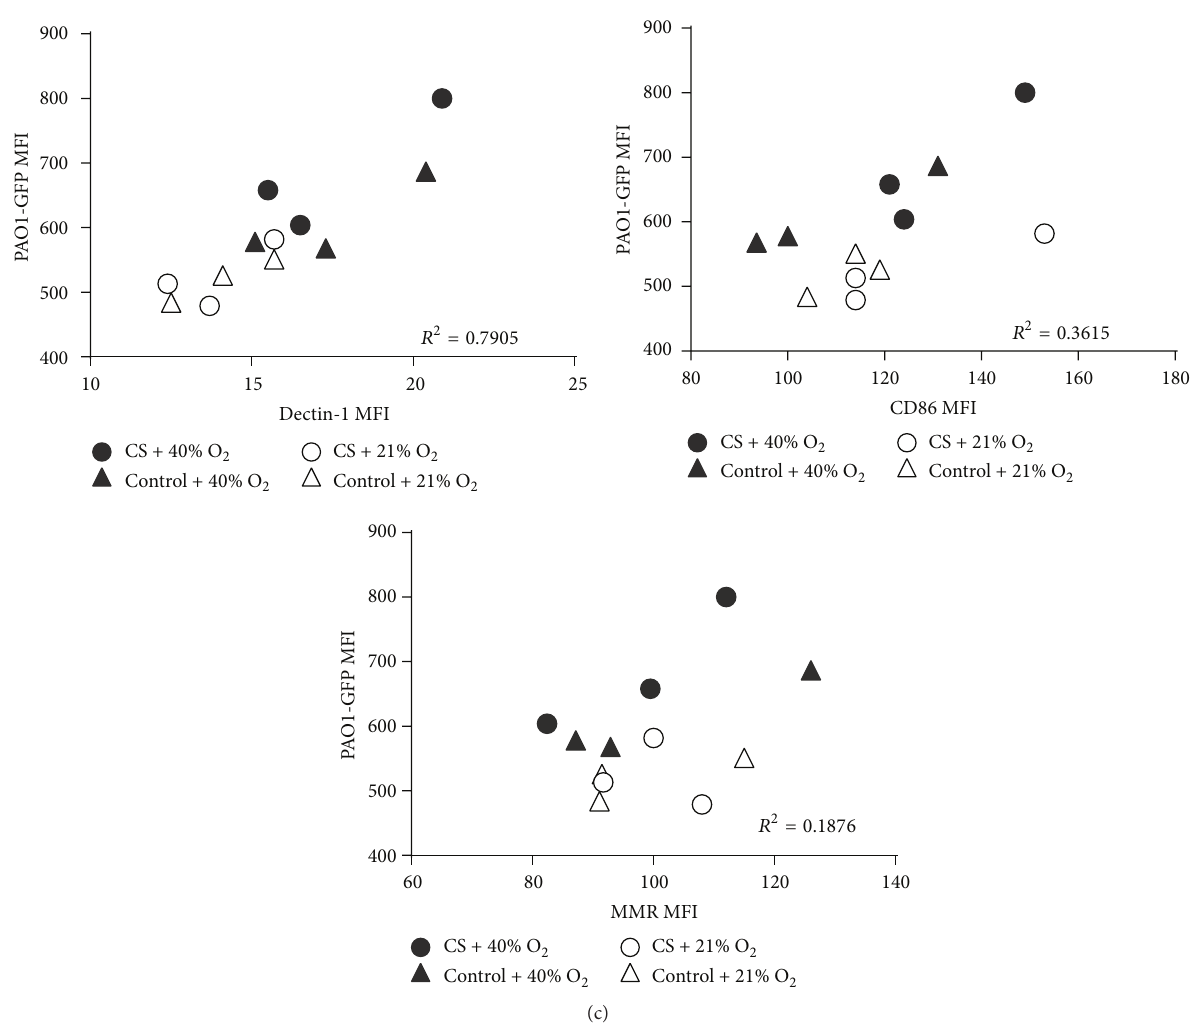
Figure 4: Oxygen modulation of macrophage phenotype may support PAO1 phagocytosis. (a) Following in vitro CS, oxygen, and PAO1 exposure, we measured TNF- 𝛼 in the supernatant ( 𝑛 = 3 , mean ± SEM, ∗∗ 𝑝 < 0.01 by one-way ANOVA compared to both 21% oxygen- exposed groups). (b) Following in vitro CS, oxygen, and PAO1-GFP exposure, we measured the MFI of cell surface expression of macrophage markers CD86, Dectin-1, and MMR using flow cytometry and expressed values normalized to control across trials (mean ± SEM, 𝑛 = 6 , ∗ 𝑝 < 0.05 compared to control + 40% O 2 group by one-way ANOVA with Bonferroni correction). (c) Using FACS, we demonstrate scatter plotsofmacrophageGFPMFIexpression(todenotePAO1macrophagebindingorengulfment)withmacrophageMFIexpressionforDectin-1 ( 𝑅 2 = 0.7905 ), CD86 ( 𝑅 2 = 0.3615 ), and MMR ( 𝑅 2 = 0.1876 ) surface